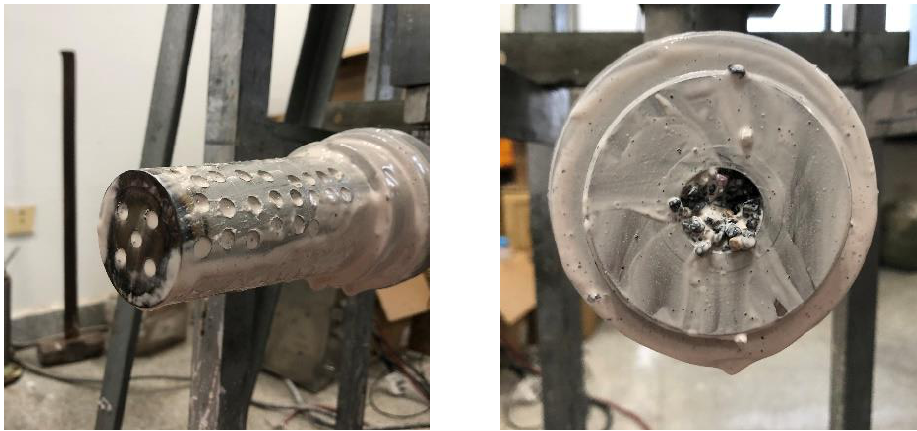
Figure 7. The mud screen tool is blocked by LCMs.